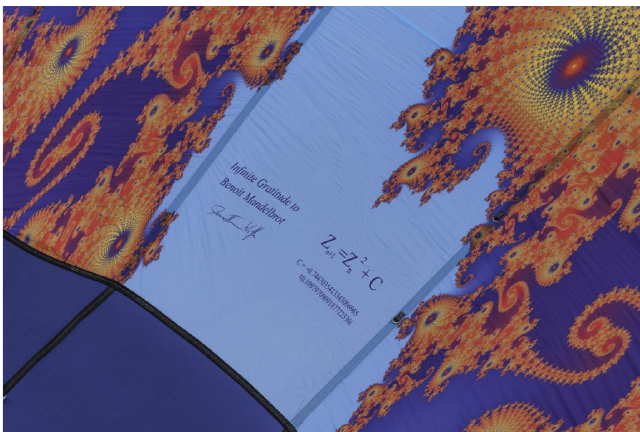
Figure 32. The mouth of “Infinitude” showing dedication to